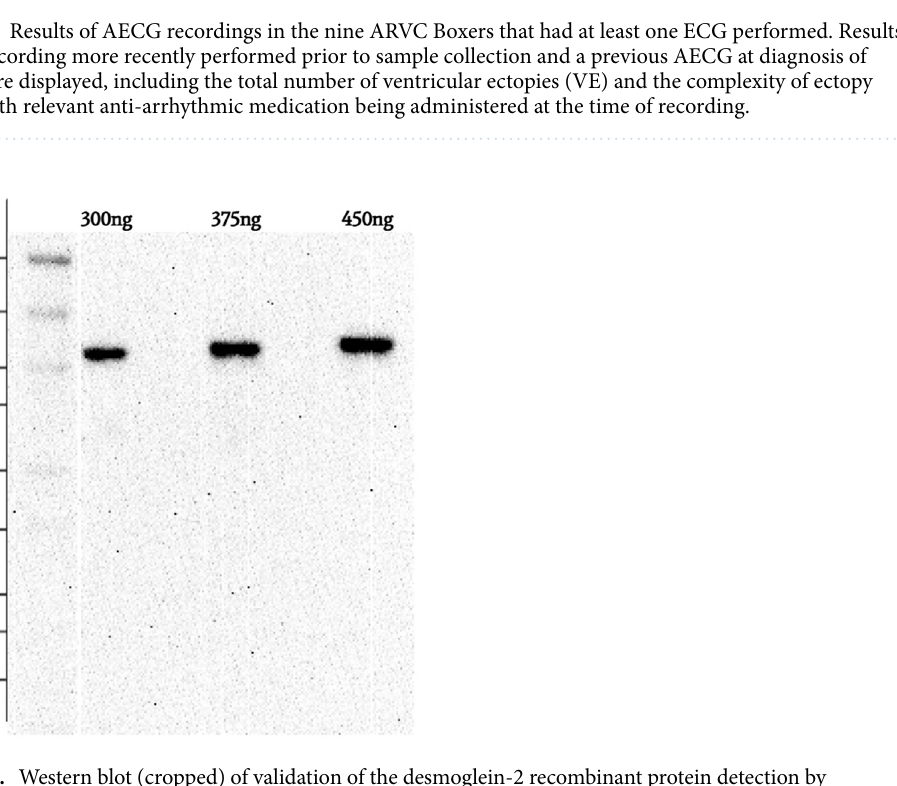
Figure 1. Western blot (cropped) of validation of the desmoglein-2 recombinant protein detection by commercially available anti-desmoglein-2 antibodies. Each well was loaded with increasing quantity (ng) of recombinant desmoglein-2 protein on the same gel. Original uncropped blot is displayed in Supplementary Figs. S1 and